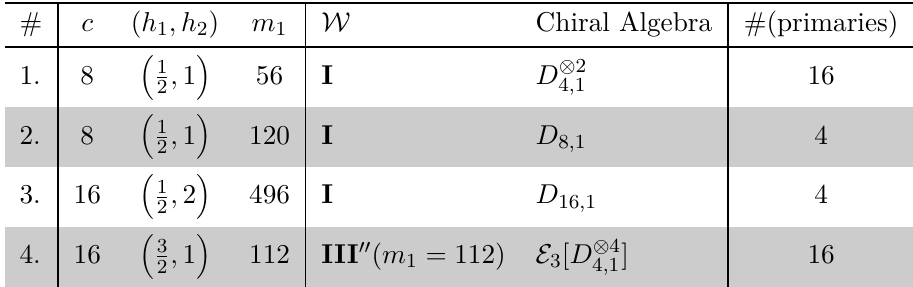
Table 29. 4 unitary (3 , 0) CFTs at c = 8 , 16